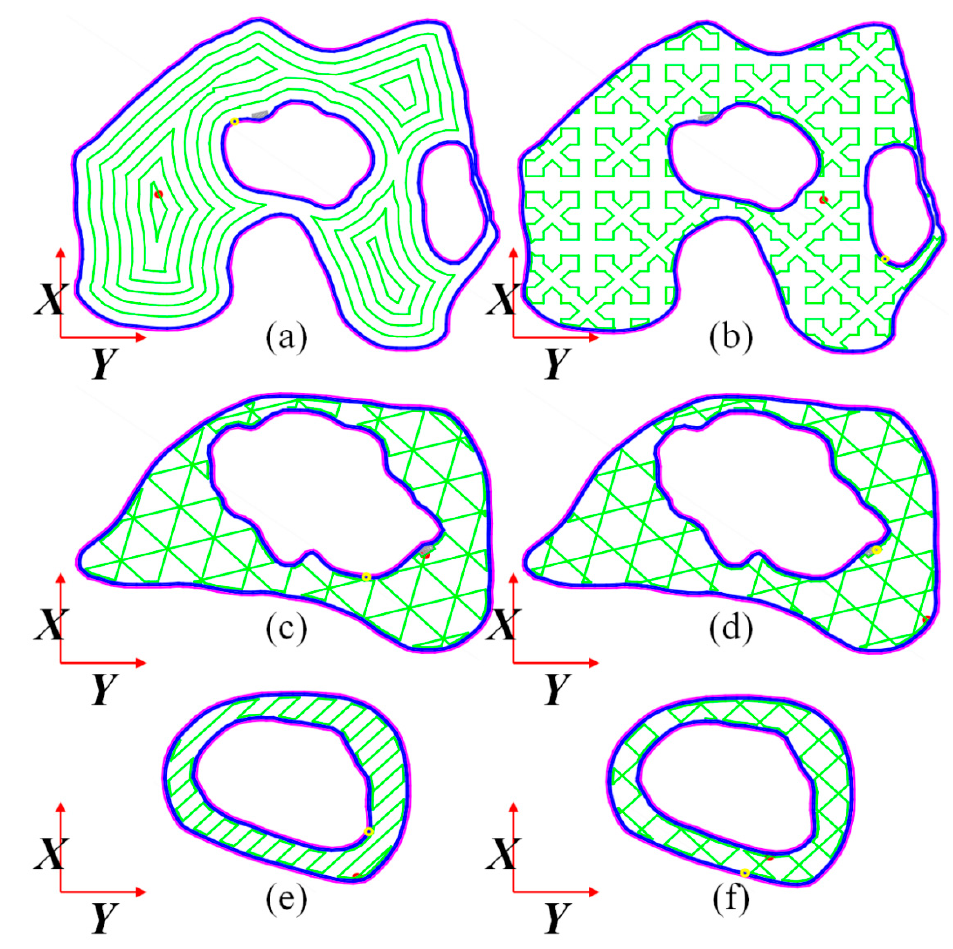
Figure 2. Six kinds of infilling patterns of femur (previously shown in Figure 1) at three layers with incremental h n , where ( a ) is concentric with h n = 0.23, L = 2162.929 and n point = 46; ( b ) is cross with h n = 0.23, L = 2215.543 and n point = 310; ( c ) is triangle with h n = 0.42, L = 1437.539 and n point = 61; ( d ) is tri-hexagon with h n = 0.42, L = 1413.658 and n point = 62; ( e ) is line with h n = 0.73, L = 822.416 and n point = 42; ( f ) is grid with h n = 0.73, L = 830.254 and n point = 29 .